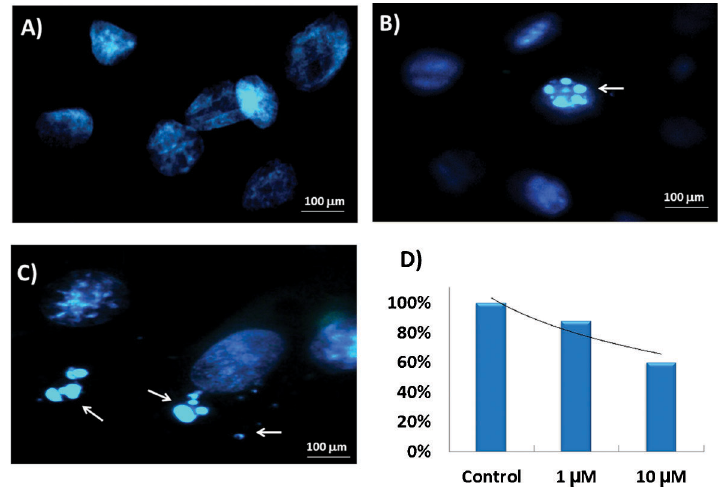
Figure 1. Nuclear morphological damage in H9c2 cells incubated with different concentrations of celecoxib for 24 h. A , 0 m M; B , 1 m M; C , 10 m M celecoxib. Cells were stained with DAPI and the arrows indicate perinuclear apoptotic/necrotic bodies. D , Percentage of nuclear morphological alteration in each group after